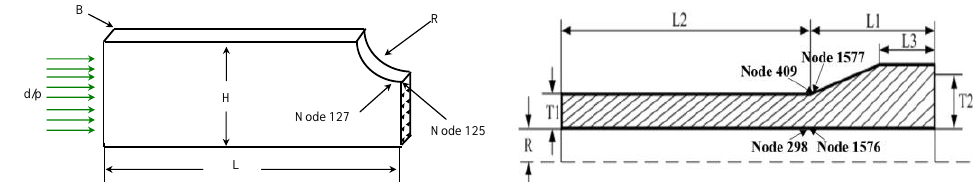
Figure 1. Notched sheet and nozzle finite element model.